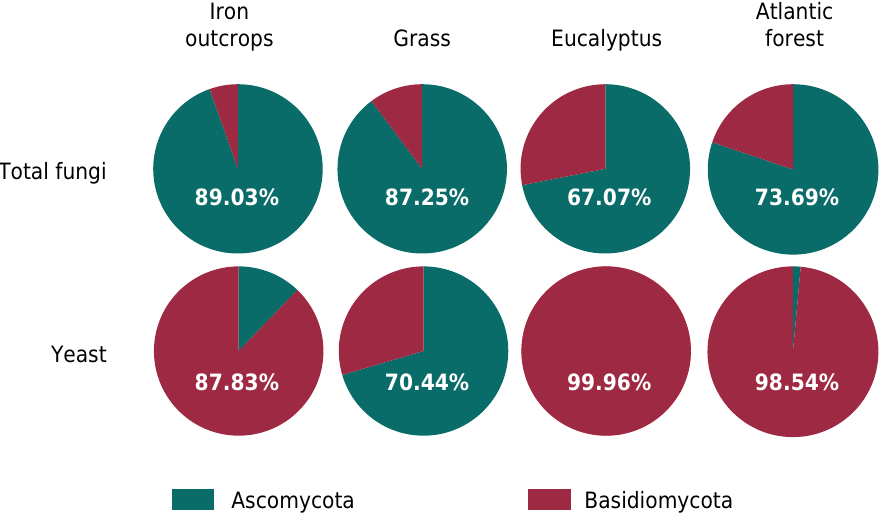
Figure 4. Ascomycota:Basidiomycota ratio for all sequences distributed among ecosystems, in both total fungi and yeasts. Percentages correspond to the dominant phylum in each